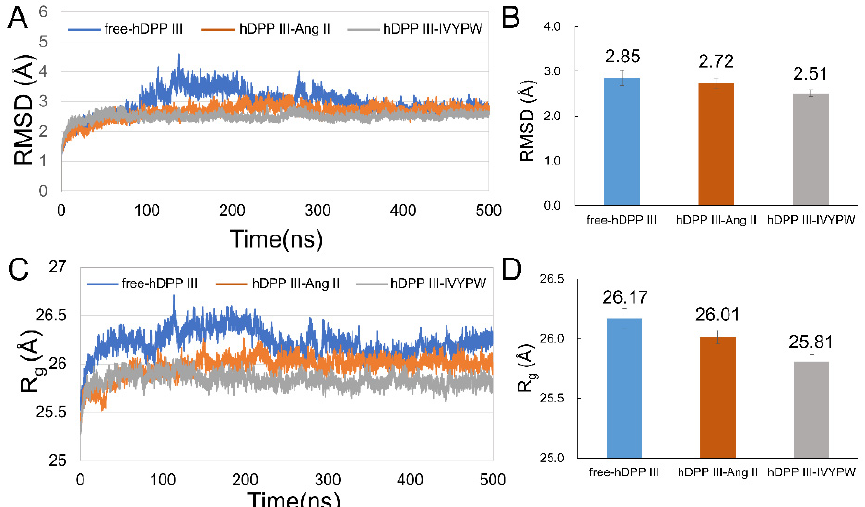
Figure 3. RMSD and R g plots of the three systems throughout 500 ns. ( A ) RMSD plot. ( B ) Average RMSD values of the last 200 ns in the MD simulations. ( C ) R g plot. ( D ) Average R g values of the last 200 ns in the MD simulations.